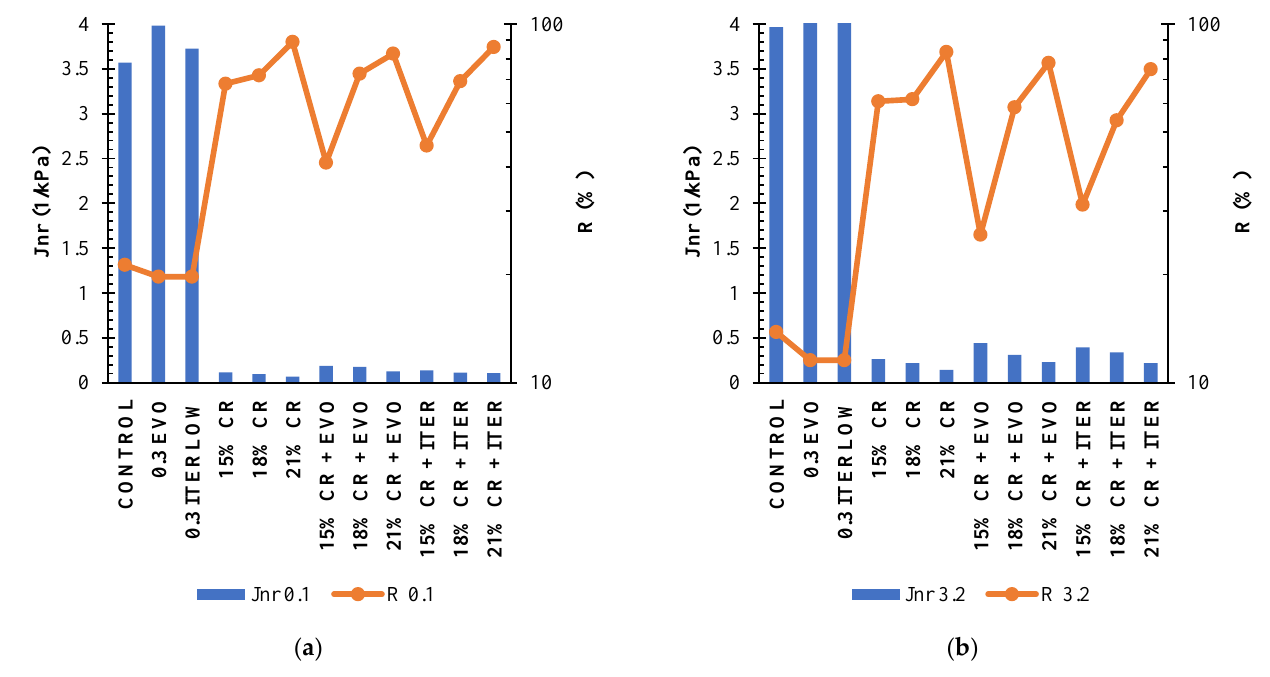
Figure 14. J nr and R of asphalt binders ( a ) under 0.1 kPa load and ( b ) under 3.2 kPa load.